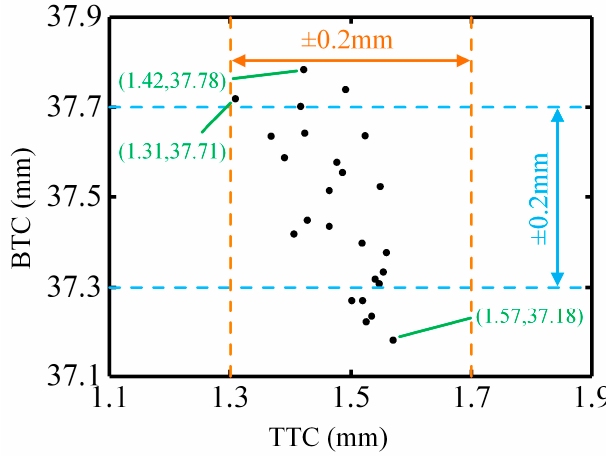
Figure 19. The vibration of BTC and TTC. Table 3. The position of TTC and